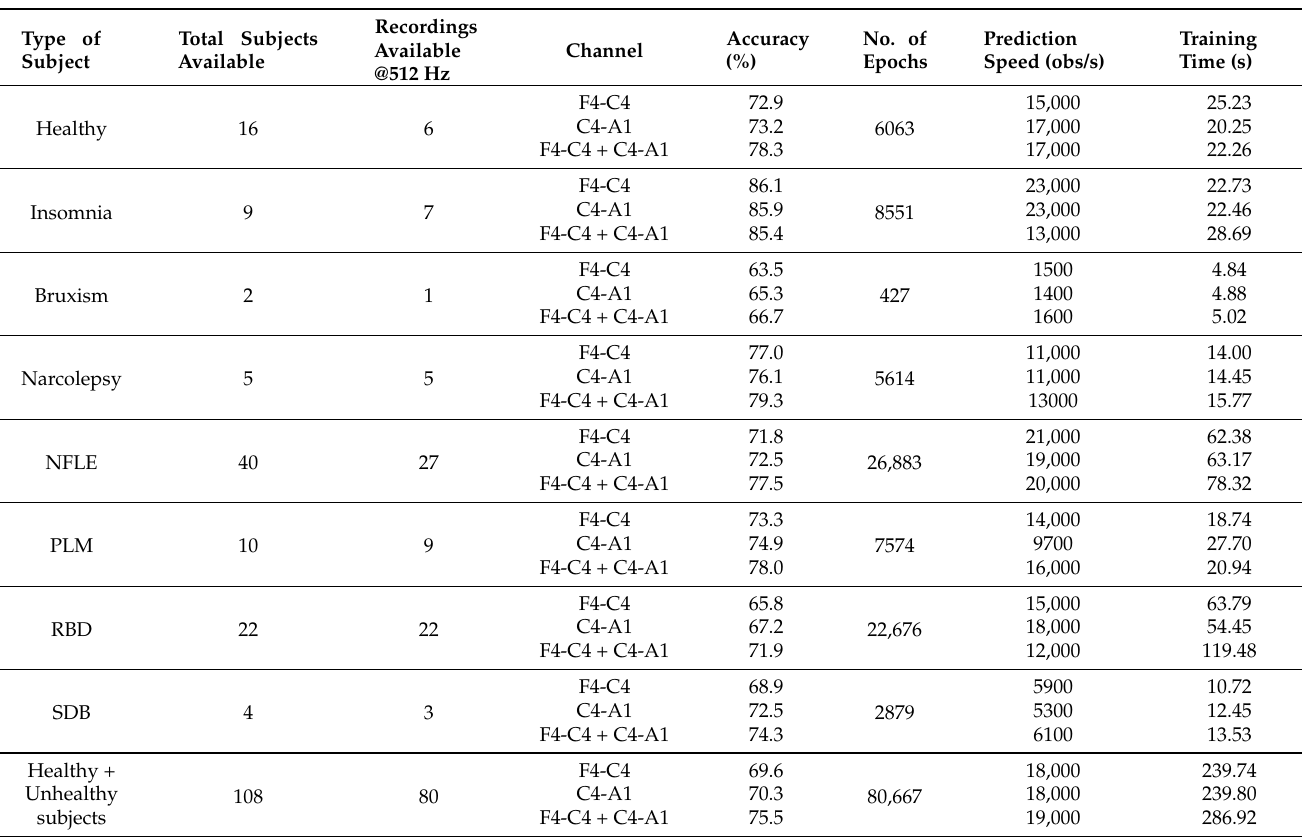
Table 8. Performance of sleep stage classification obtained using the unbalanced dataset and EBT classifier with 10-fold CV. Type of Subject